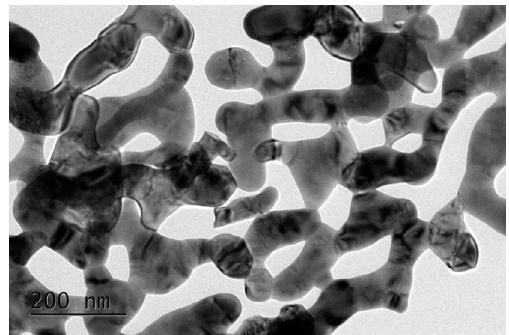
Fig. 6 TEM photos of SmAlO 3 powders calcined at 750 ℃ for 2 h.